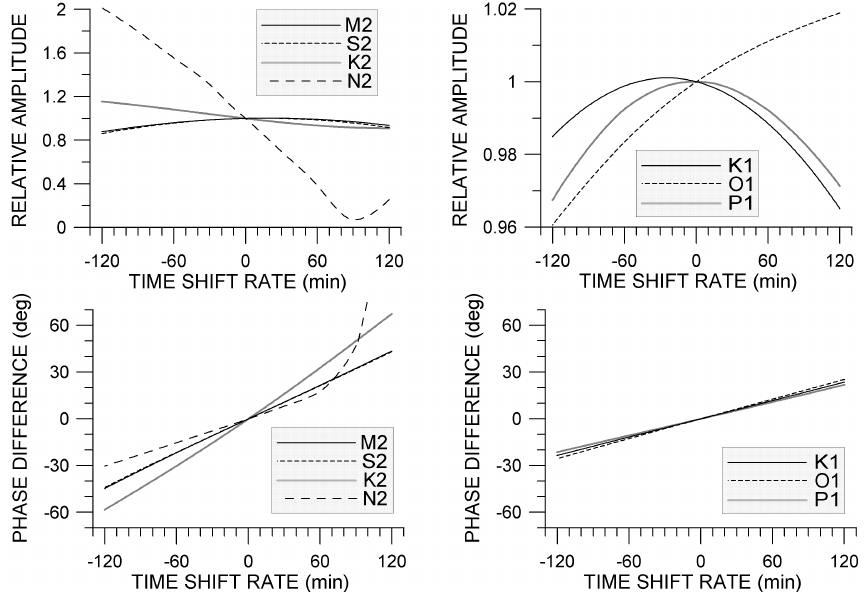
Fig. 8. Simulated changes in relative amplitudes and phase differences versus the time shift rate. The respective amplitude and phase are supposed to be 1 and 0 when no time shift was